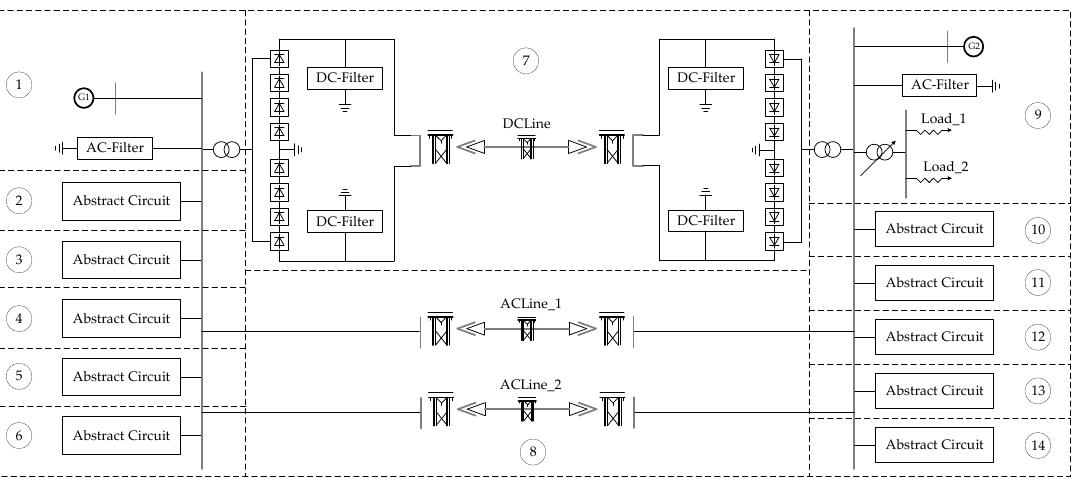
Figure 7. Test model after processing.